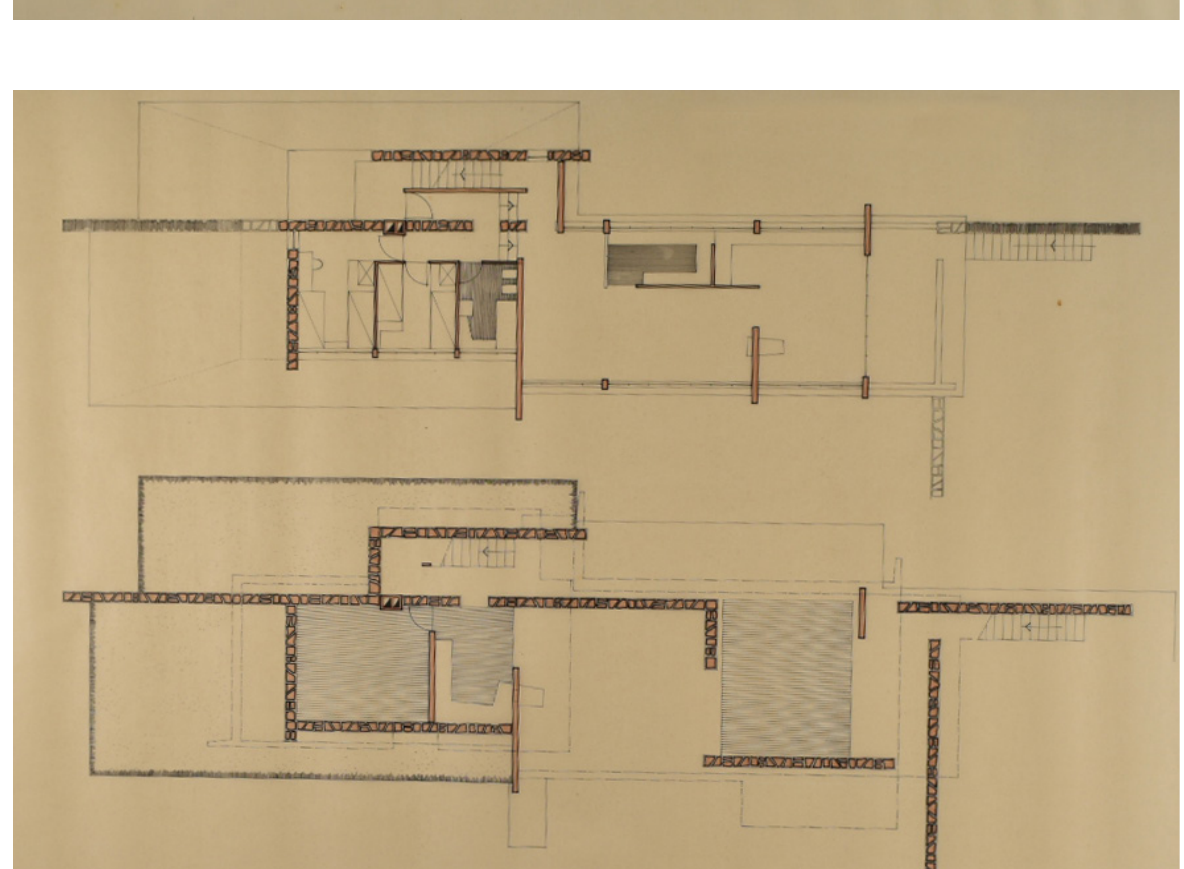
IMG.8: Project for three